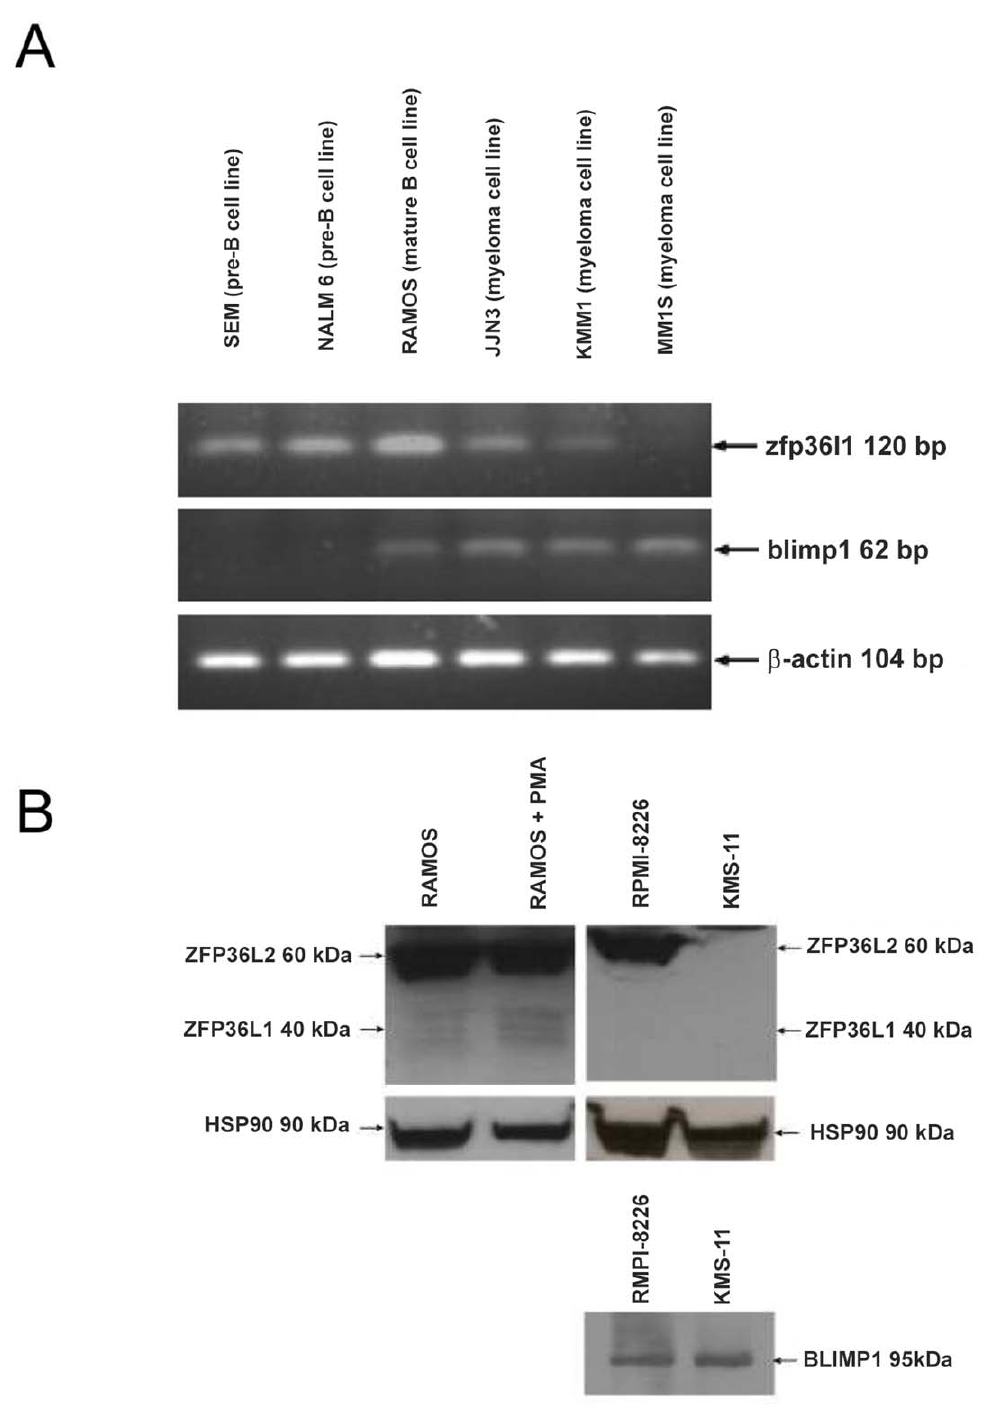
Figure 1. ZFP36L1 expression in human B cells at various stages of differentiation. (A) RT-PCR analysis of ZFP36L1 expression in human malignant B cells representing different stages of B cell differentiation. For comparison BLIMP1 expression was also measured. b ACTIN expression levels are shown as a loading control. (B) Comparison of ZFP36L1 protein levels in human Ramos B cells before and after 3 h PMA stimulation and in two myeloma cell lines RPMI-8226 cells and KMS-11. BLIMP1 expression is also shown in RPMI-8226 cells and KMS-11 cells. HSP90 levels are shown as a loading control. ZFP36L1/L2, HSP90 and BLIMP1 proteins were detected by anti-BRF1/2, anti-HSP90 and anti-BLIMP1 antibodies respectively. Anti- BRF1/2 antibody cross-reacts with ZFP36L2 (approx. 60 kDa) and ZFP36L1 appears typically as a constellation of induced bands (approx. 40 kDa) in human cells.